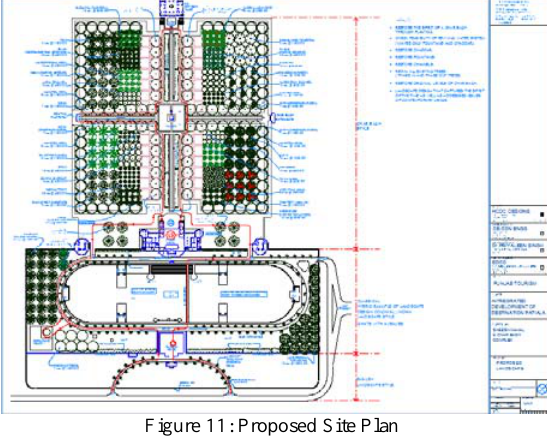
Figure 11: Proposed Site Plan The site is divided into three segments